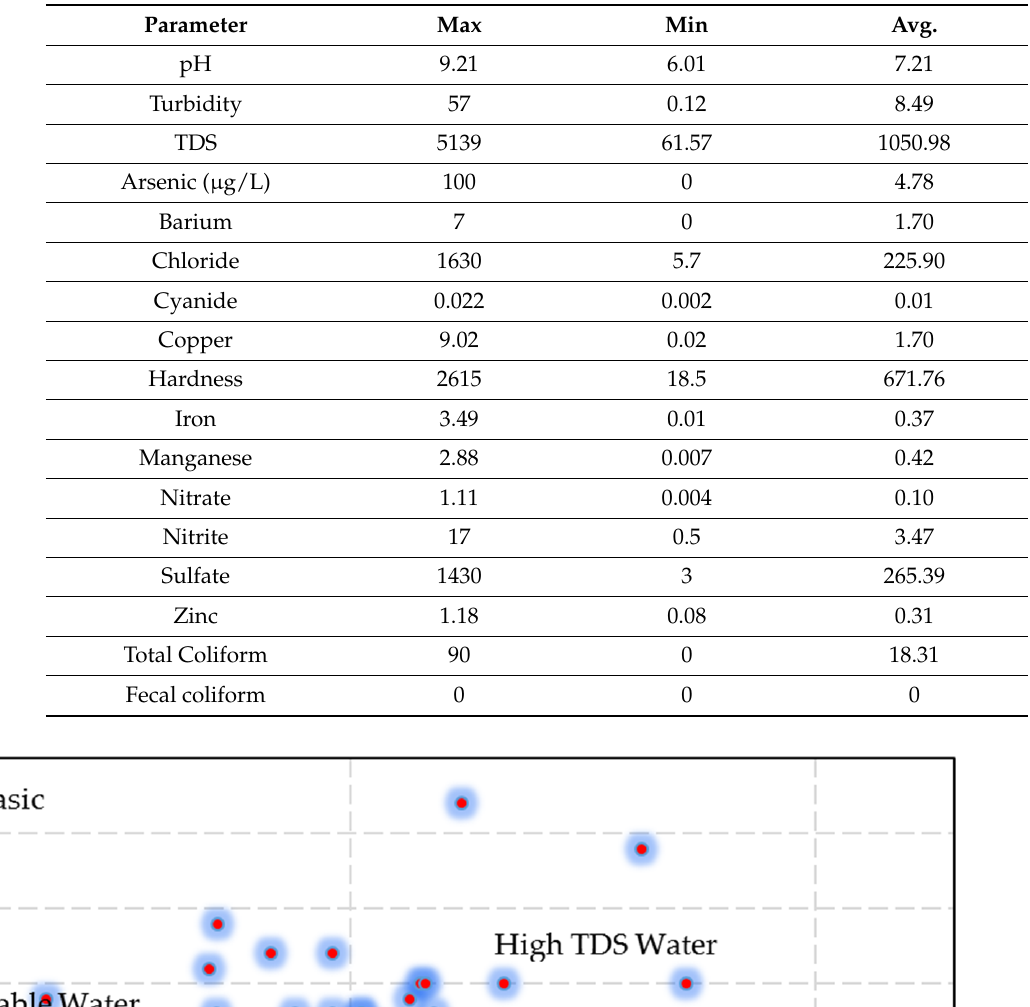
Table 4. Descriptive statistics of water samples in the study area. Units for all constituents are in mg/L except for As which is in µ g/L.